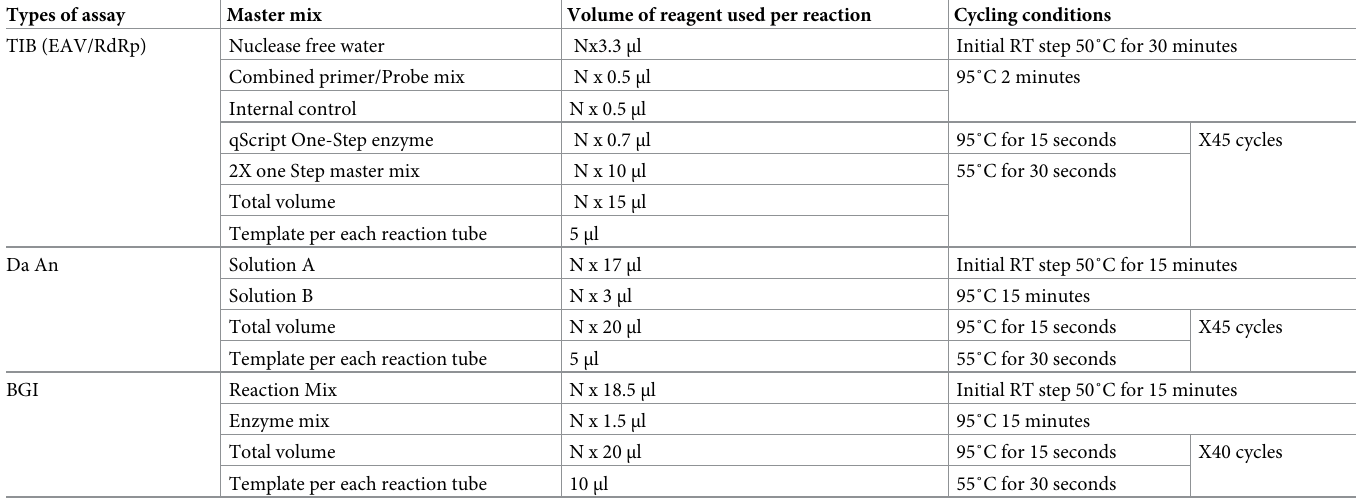
Table 2. RT-PCR test kits with their corresponding master mix protocols used in this study, Addis Ababa, Ethiopia, 2021. Types of